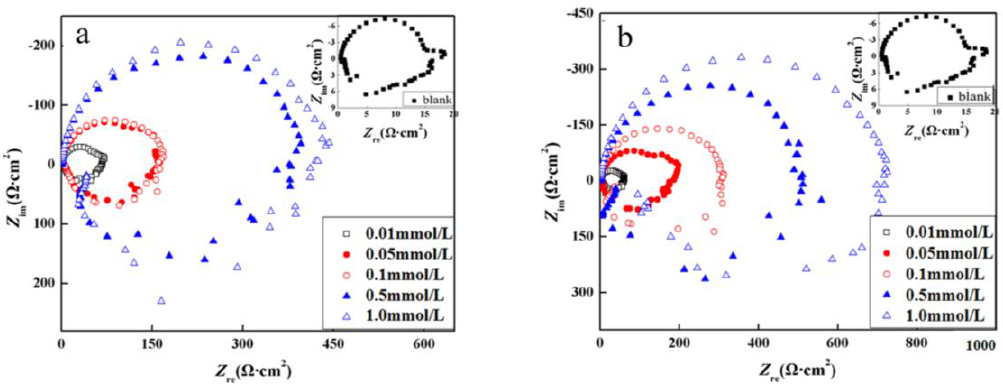
Figure 5. Nyquist diagrams for aluminum alloy in 1 M HCl containing different concentrations of ( a ) DAN and ( b ) DBN.